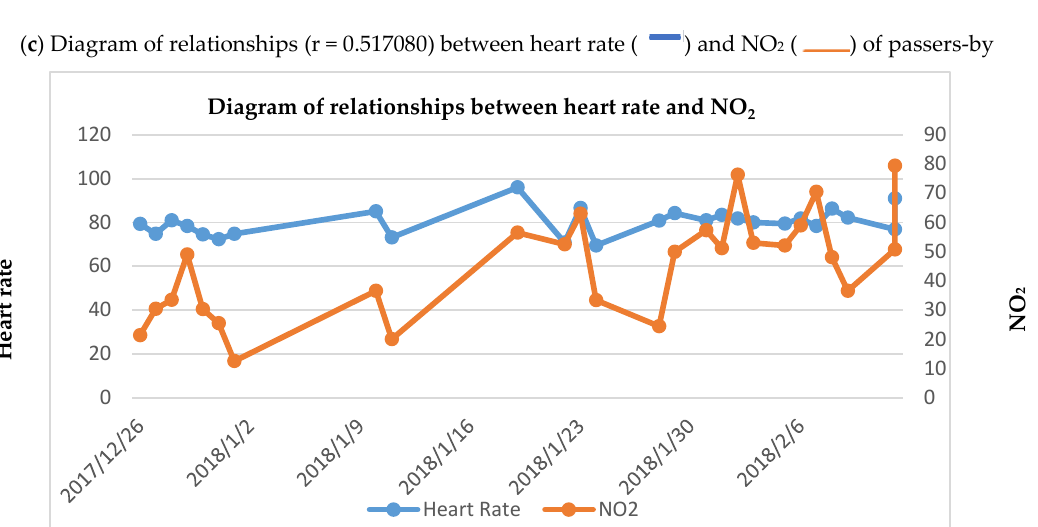
Heart Rate KD10